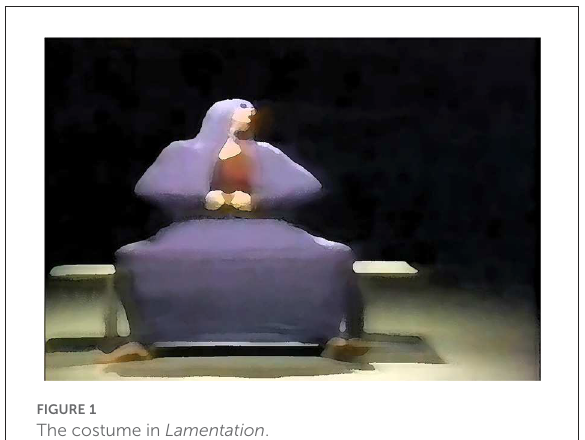
FIGURE1 The costume in Lamentation